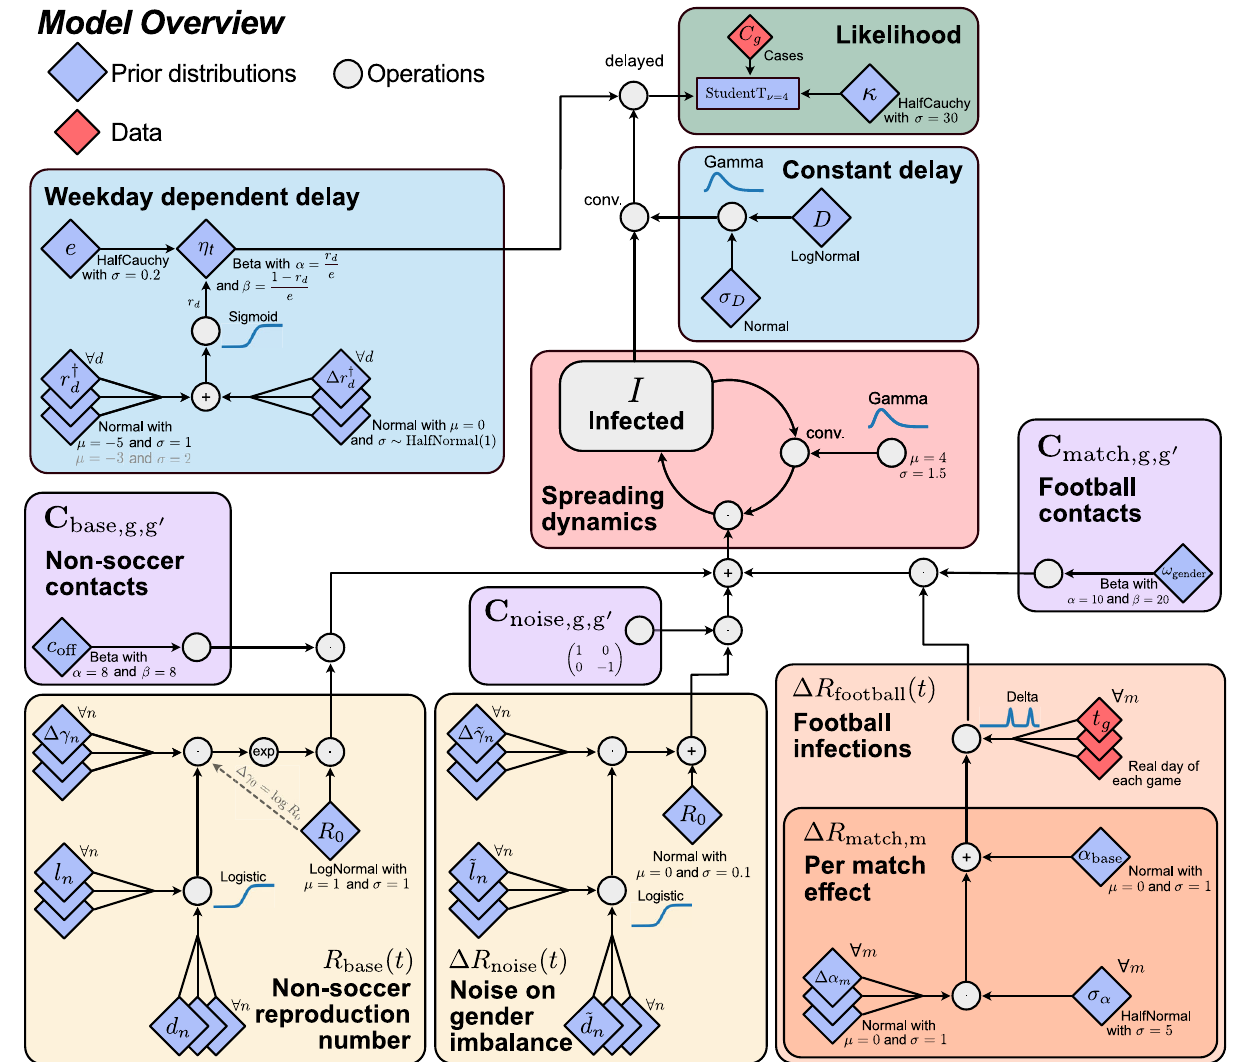
Fig. 4 | Model overview illustrating the relationship between the chosen prior distributions and the disease dynamics. Boxes in the fl owchart are color-coded accordingtowhattheydescribe.Lightblueboxes:delaymodulations.Greenboxes: likelihoods.Redboxes:spreadingdynamics.Purpleboxes:contactmatrices.Yellow